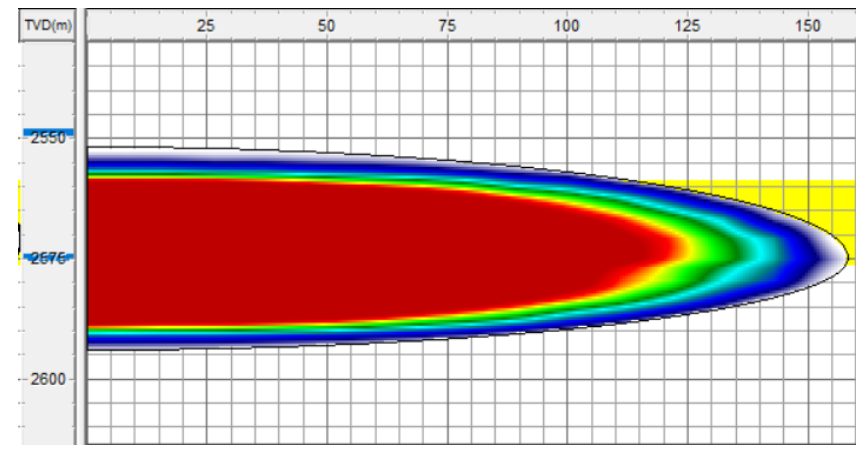
Figure 17. Fracture morphology after fracturing.